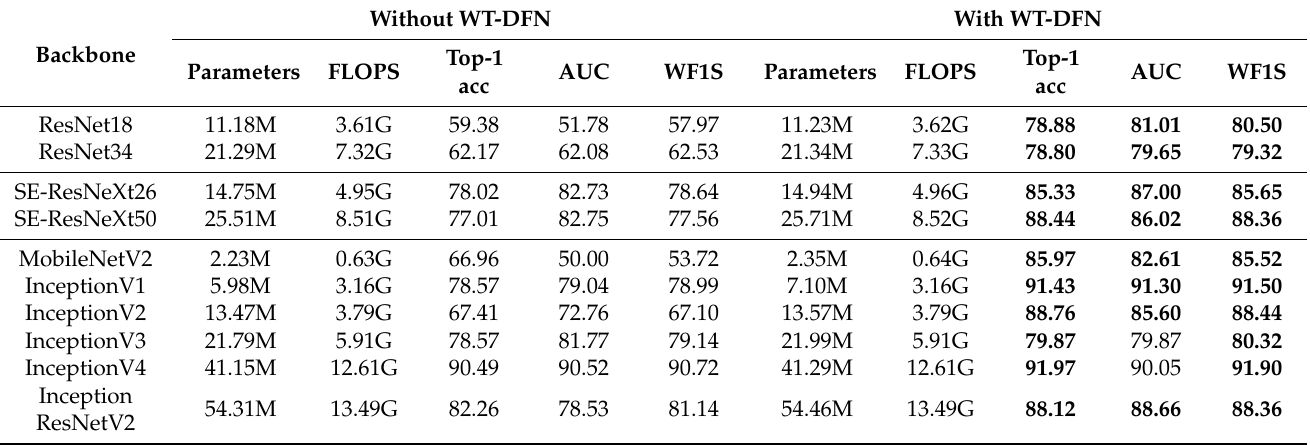
Table 3. Comparison with state-of-the-art methods on PD.